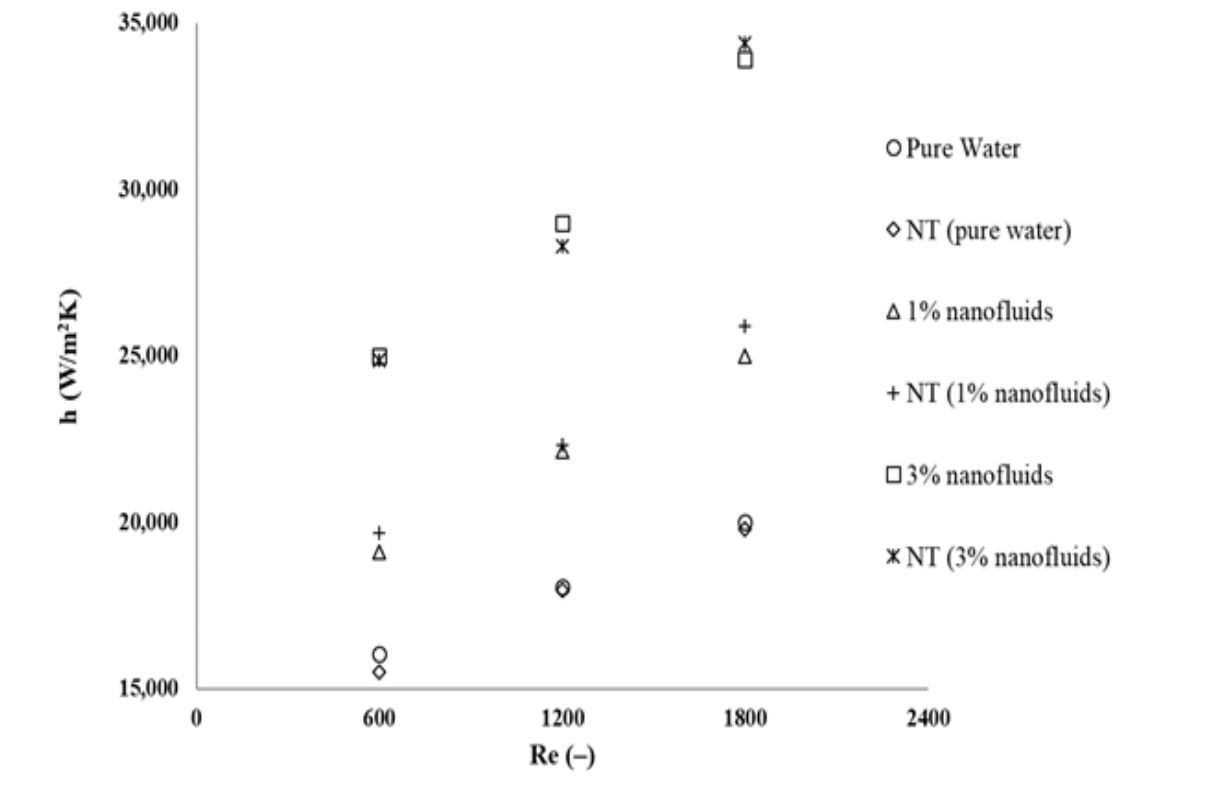
Processes 2022 , 10 , x FOR PEER REVIEW 10 of 15 Figure 5. Comparison of the heat transfer coefficients values for different Reynolds numbers with water and water/Al 2 O 3 fluids obtained using the numerical tests (NT) with the results given in Shi et al. [17].